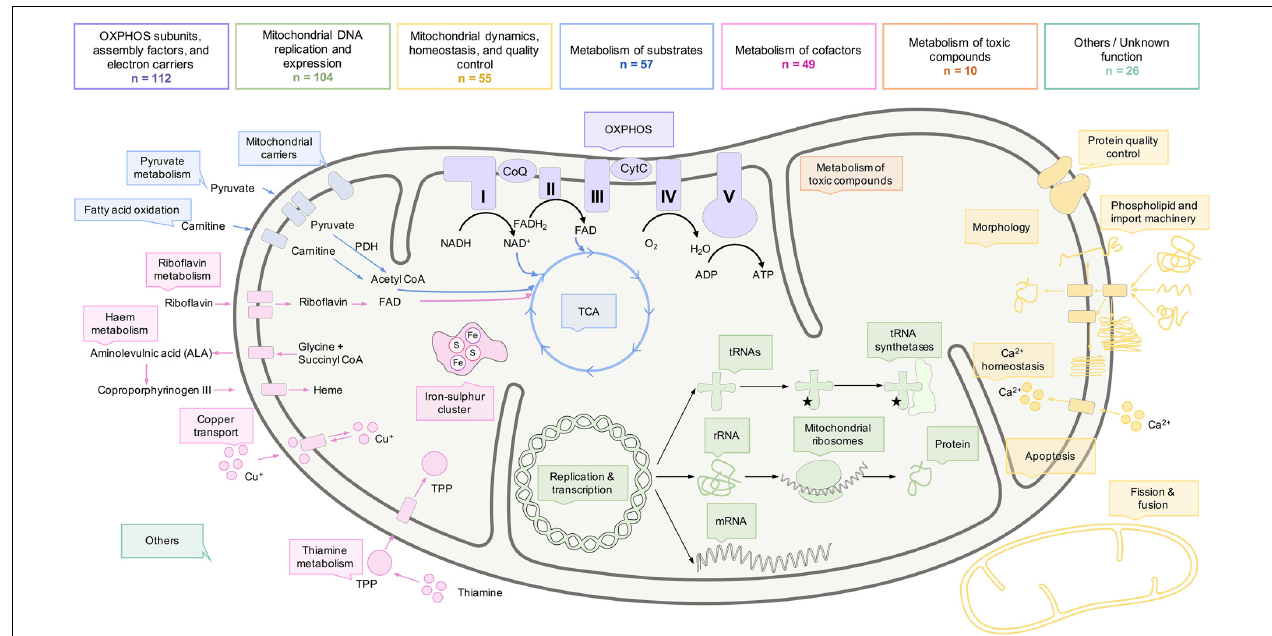
FIGURE 4 | Functional roles of mitochondria and the biochemical processes within a mitochondrion. Although the OXPHOS is considered as the hallmark of mitochondria, multiple proteins with a wide range of functional roles influence the metabolism of mitochondria. Some of the functions and biochemical processes of mitochondria, commonly defective in mitochondrial diseases, are illustrated here. The number of mitochondrial disease genes implicated in the biochemical pathways is indicated. Genes with multiple functions were only listed within one category.